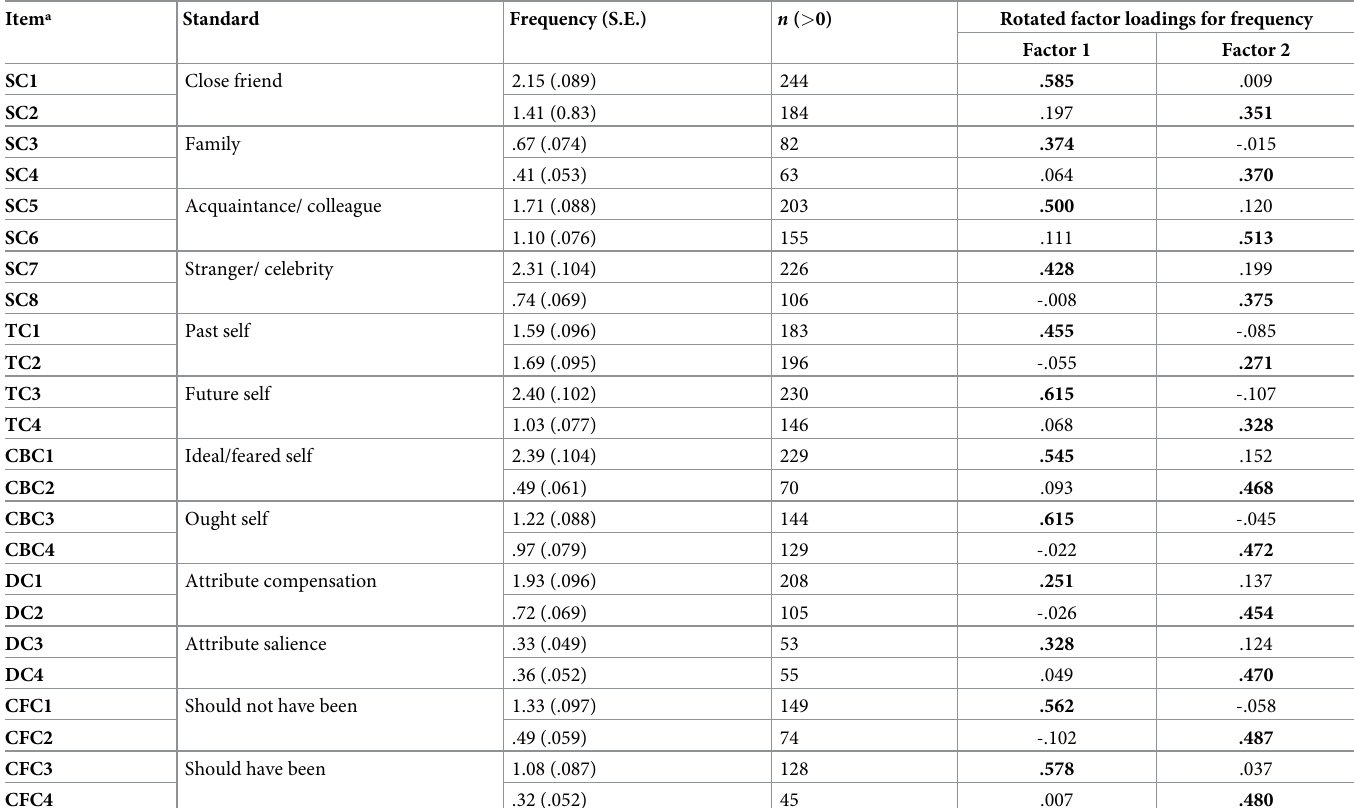
Table 2. Comparison standards scale